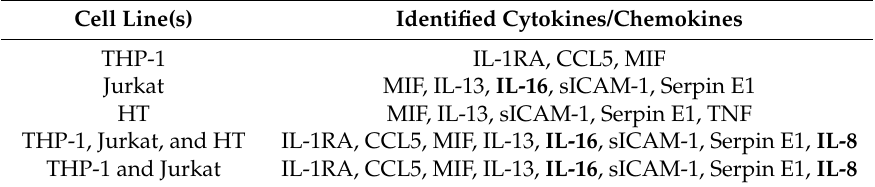
Table 1. Cytokines/chemokines expressed by HMWH-treated THP-1, Jurkat, and HT cells as determined by Proteome Profiler Human XL Cytokine Array. T cell-specific IL-16 and co-culture-specific IL-8 are highlighted in bold.